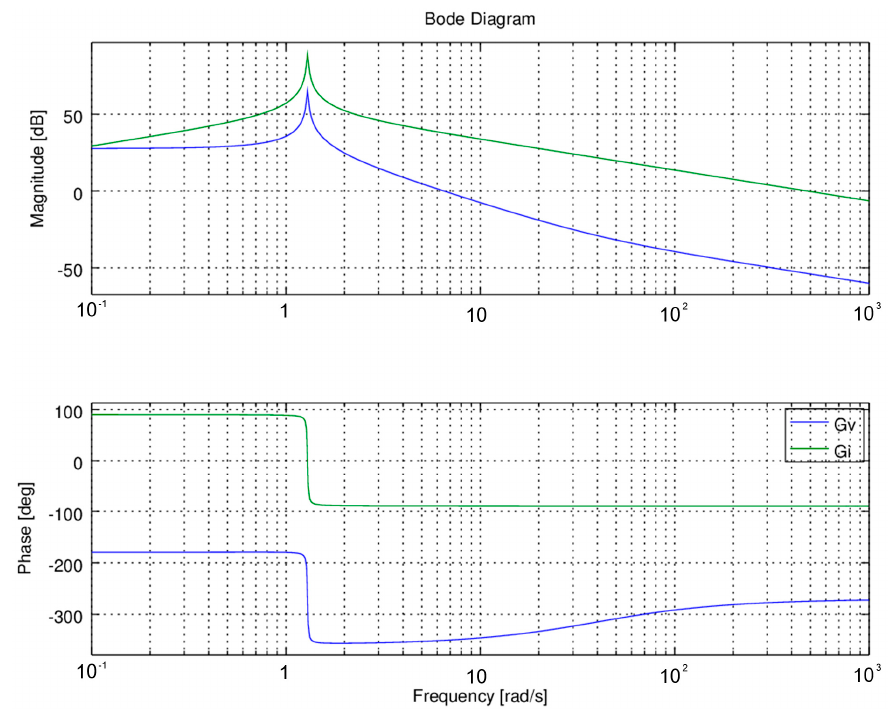
Figure 9. Bode diagram of the voltage loop and current loop transfer functions.